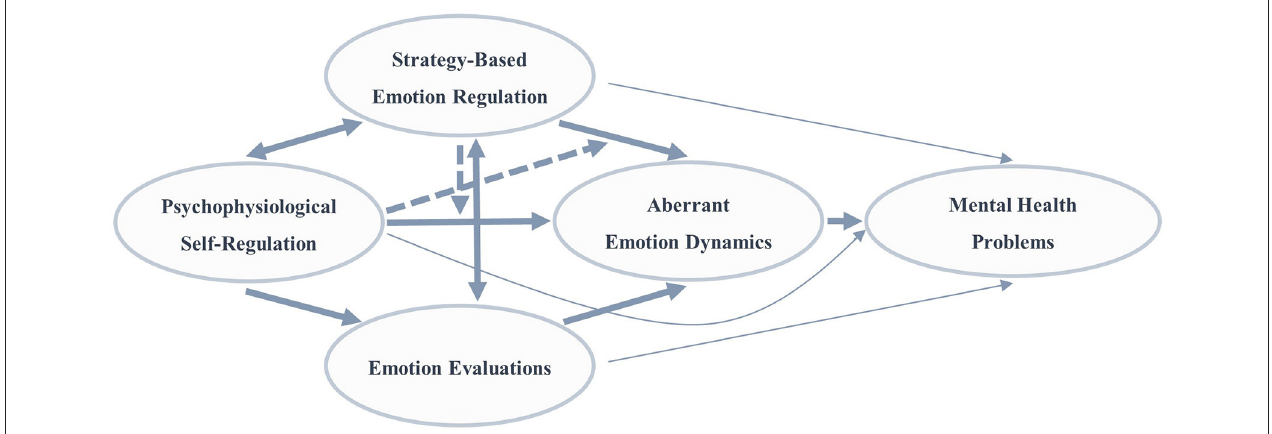
FIGURE 2 | Graphical illustration of the integrative framework of dysregulated emotion. Emotional dysregulation is assumed to occur as a result of the interplay between strategy-based emotion regulation, psychophysiological self-regulation, and emotion evaluations and to be reflected in aberrant emotion dynamics. Mental health problems are expected to result from dysregulated emotion. Hypothesized paths are indicated by arrows. Solid bold arrows depict direct associations or mediations via another domain. Dotted arrows illustrate moderation effects. Besides their main path via aberrant emotion dynamics, all domains are also assumed to be directly associated with mental health problems, represented here via thin